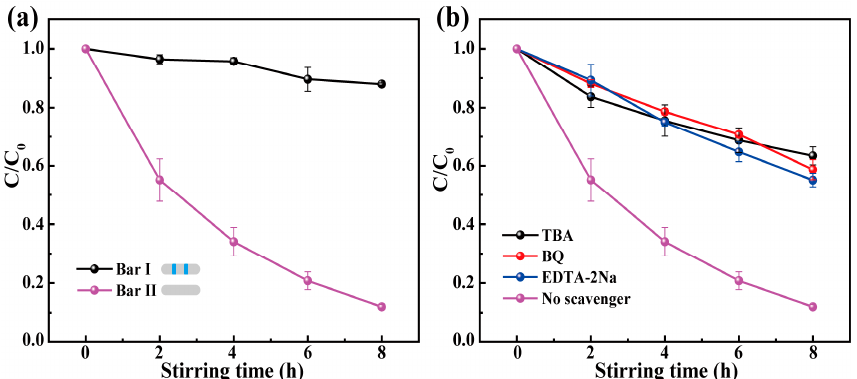
Figure 7. ( a ) Tribocatalytic degradation performance of BST ‐ 0.2 nanopowders for RhB solution under the conditions of contact or incomplete contact between the magnetic bar and the bottom of the beaker (modified magnetic bar with two rubber rings, noted as Bar I); ( b ) Effect of scavengers on the tribocatalytic performance of BST ‐ 0.2 nanopowders.